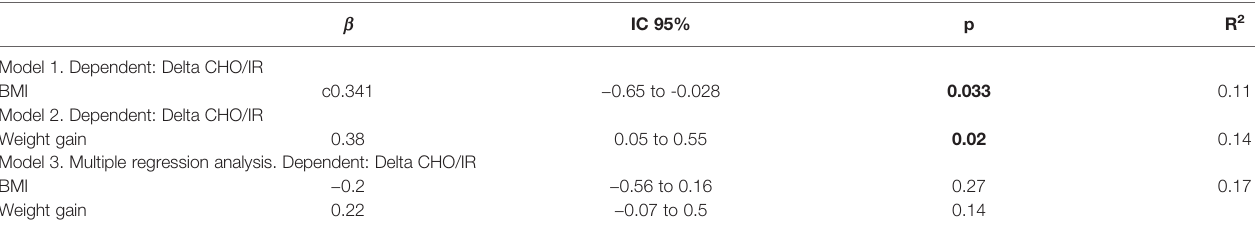
TABLE 5 | BMI, weight gain and CHO/IR decrease at breakfast: univariate and multiple regression analysis. b IC 95% p R 2